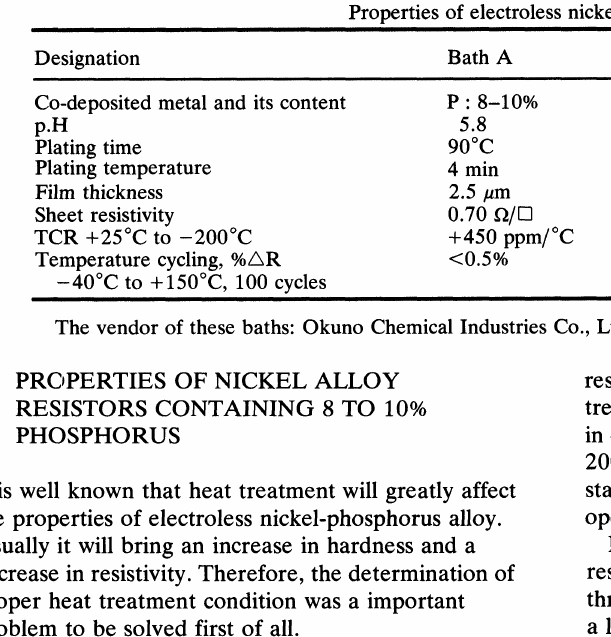
TABLE Properties of electroless nickel plating baths.